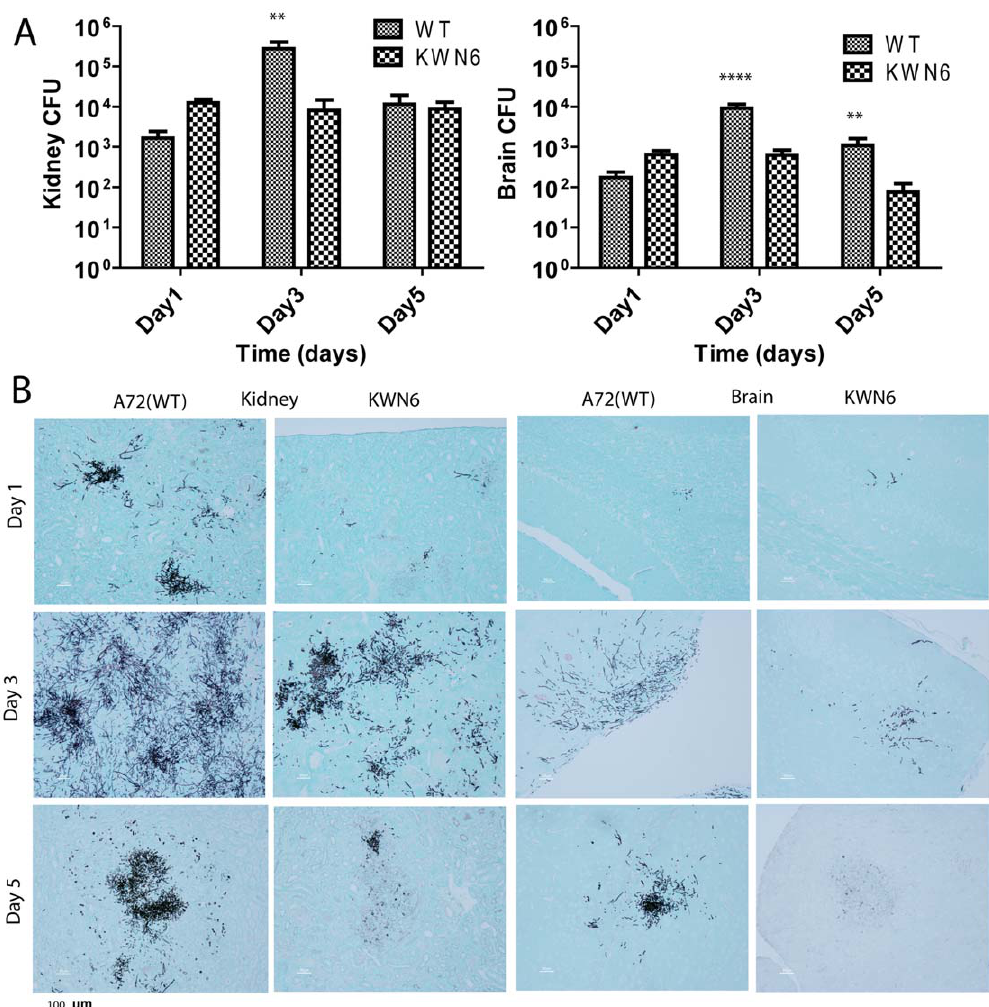
Figure 2. Dur1,2p expression promotes kidney and brain colonization. ( A ) . Kidney and brain fungal burdens of mice infected with parental A72 and mutant KWN6 strains. Gray bars represent mean CFU of WT infected left kidney homogenates determined by CFU on BiGGY agar from six representative serial dilutions from each kidney, representing three mice per time point infected. Checkered bars represent similar mean values for mice administered with KWN6. (B) GMS-stained mouse kidney and brain tissues to determine C. albicans colonization. Representative kidney and brain sections harvested day 1, 3 and 5 PI from mice infected with WT or KWN6 are shown. Scale bar indicates 100 m m.